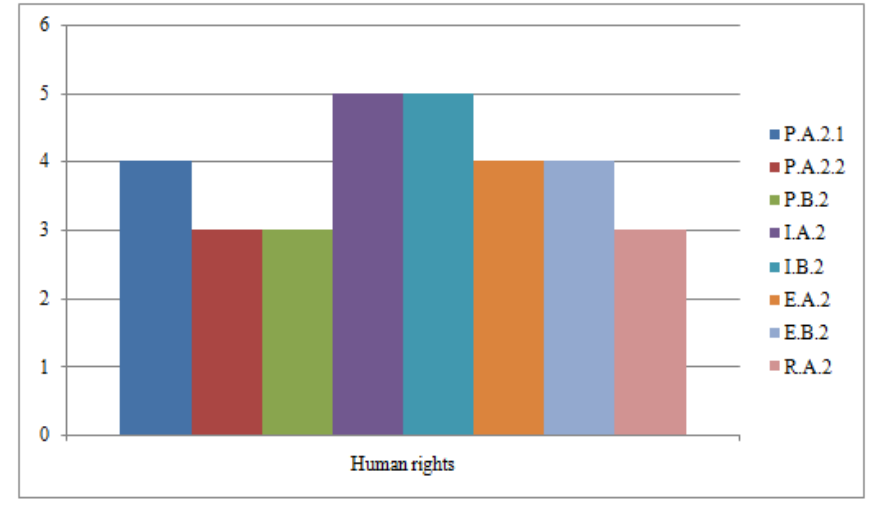
Figure 5. Degree of fulfillment for human rights responsibility indicators.